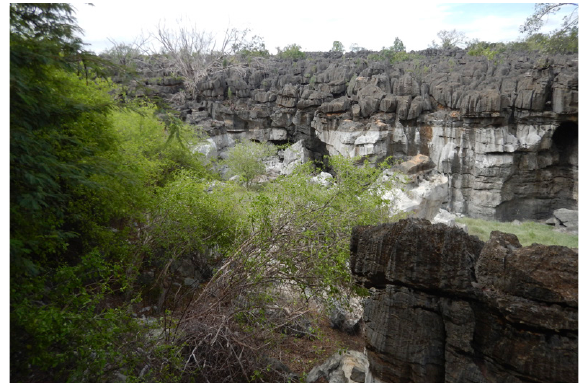
Figure 3. Karstic landscape surrounding Toca de Candeias, Cen- tral, Bahia state, Brazil. Photo by M.E. Bichuette.